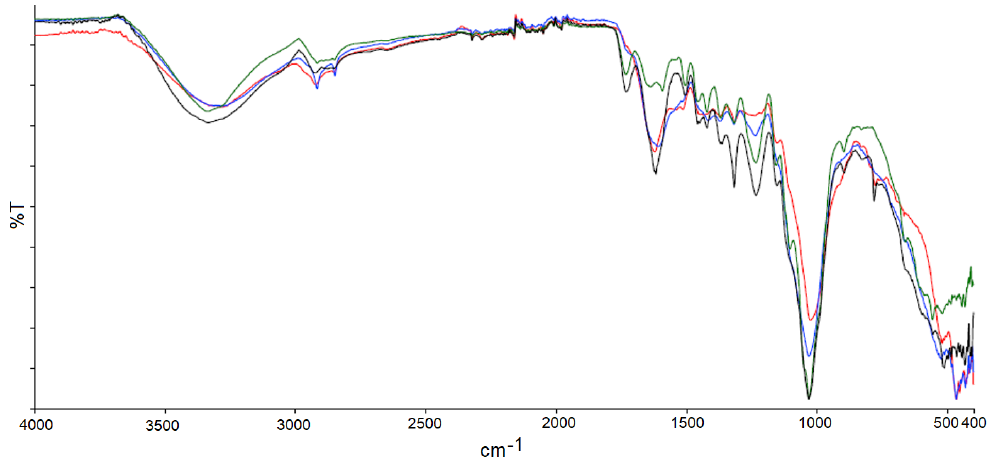
Figure 1. FTIR-ATR overlap for Licorice Root (L, red), Palm Leaf (P, blue), Willow (W, green) and Holm Oak (OH, black).